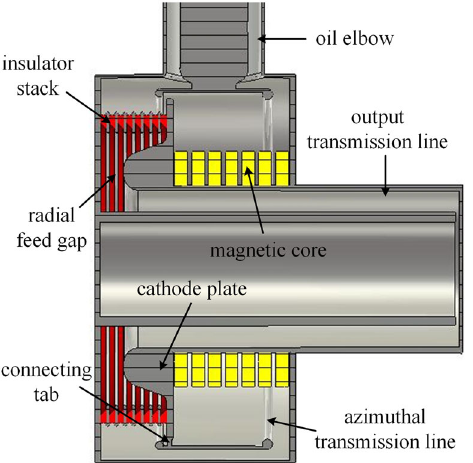
FIG. 1. Schematic cross section of an induction cavity which mainly includes oil elbow, azimuthal transmission line, connect- ing tab, insulator stack, radial feed gap, cathode plate, magnetic core and output transmission